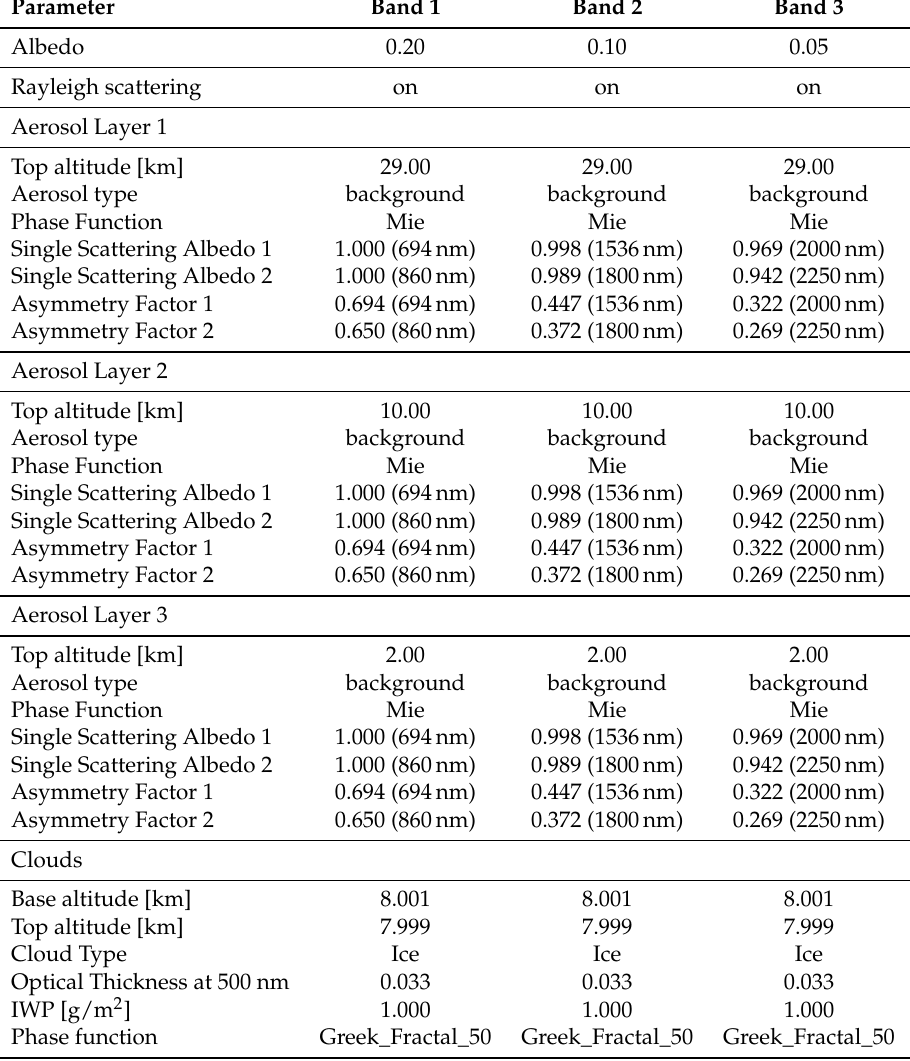
Table A12. Scattering parameters of scenario Rayleigh+Aerosol BG+Ice cloud